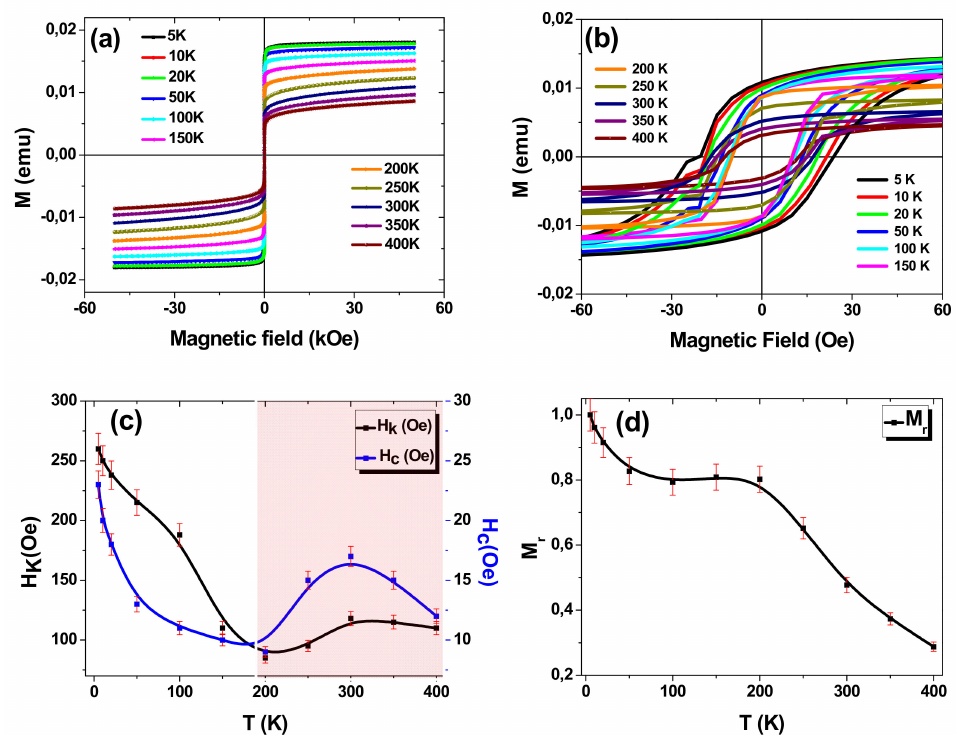
Figure 3. ( a ) Hysteresis loops, measured in magnetic field applied parallel to the axis of microwires in the temperature range from 5 to 400 K for as prepared Co 2 FeSi G-CMMWs, and measured magnetic field between ± 50 kOe and ( b ) hysteresis loops with low scale magnetic field. ( c , d ) temperature dependence of the coercivity and anisotropy field and normalized remanence, respectively, for Co 2 FeSi G-CMMWs (lines for eye